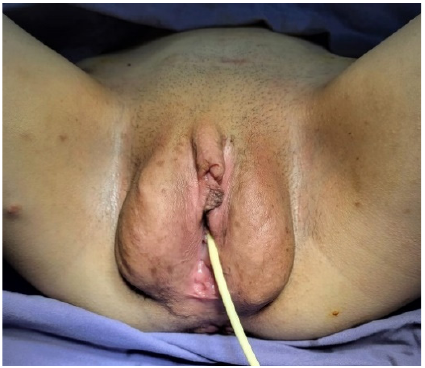
Figure 1. Hypertrophy of the labia majora (plexiform neurofibroma).